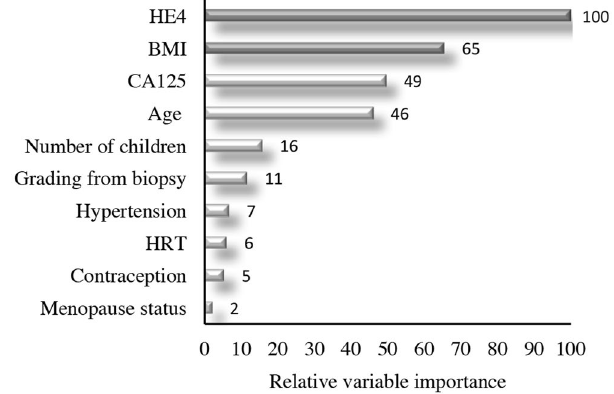
Figure 3. Relative variable importance measure. Total Decrease in Node Impurity- obtained by Random Forests on the subgroup of 219 endometrioid EC patients preoperatively classified as early stage (clinical stage).